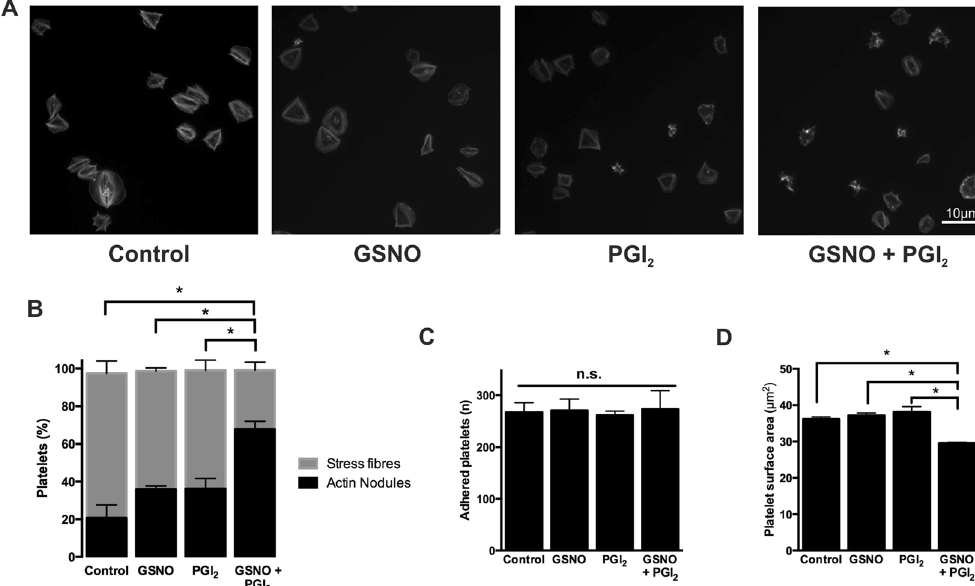
Figure 5. Synergistic effect of NO and PGI 2 on the spread platelet actin cytoskeleton. Platelets (2 × 10 7 /ml) were allowed to spread on fibrinogen-coated glass coverslips for 25 minutes prior to being treated with buffer, GSNO (10 nM), PGI 2 (300 pM) or both for a further 20 minutes. ( A ) Representative fluorescence images acquired using the Zeiss Axio Observer microscope at x63 magnification ( B ) Proportion of platelets with stress fibres and actin nodules following treatment as indicated; ( C ) Number of platelets adhered following treatment as indicated; ( D ) Mean platelet surface area of spread platelets following treatment as indicated. Data represents three separate experiments. Error bars represent S.E.M, with significance ( * ) defined as p < 0.05. Scale bar is representative of 10 μ